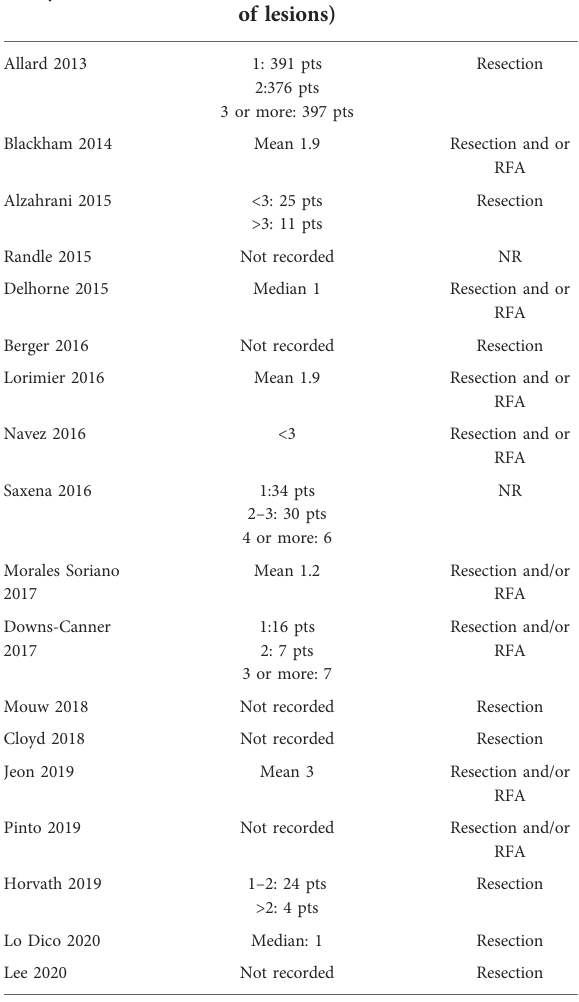
TABLE 3 Extent of liver disease and types of liver treatments.